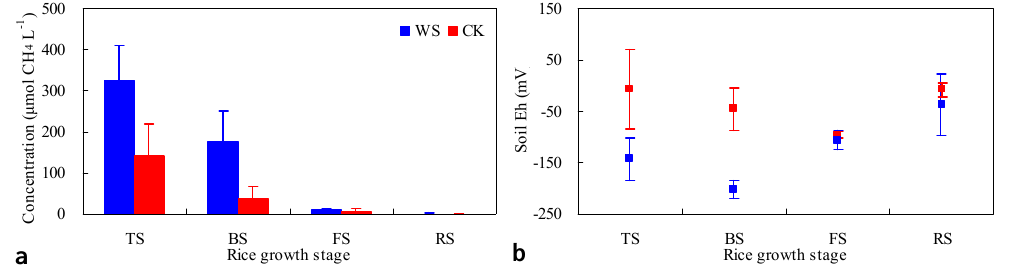
Fig. 1. CH 4 concentration in soil solution (a) and soil E h of the field (b) at the four rice growth stages. TS: tillering stage, BS: booting stage, FS: grain-filling stage, RS: ripening stage. WS: straw incorporation, CK: without straw incorporation. Mean ± SD, n =